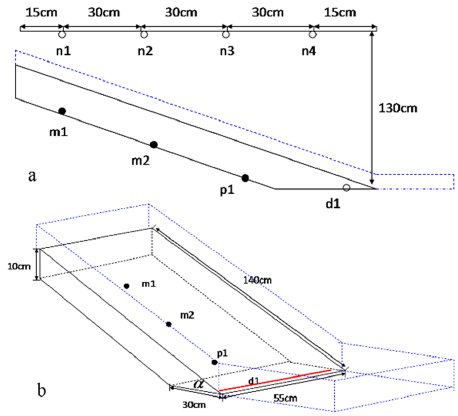
Figure 2. Physical slope model: ( a ) side view and ( b ) stereoscopic view, where n1, n2, n3 and n4 are nozzles for rainfall; m1 and m2 are moisture transducers; p1 is the pore water pressure transducer; d1 is drainage ditch; and α is ~26 ˝